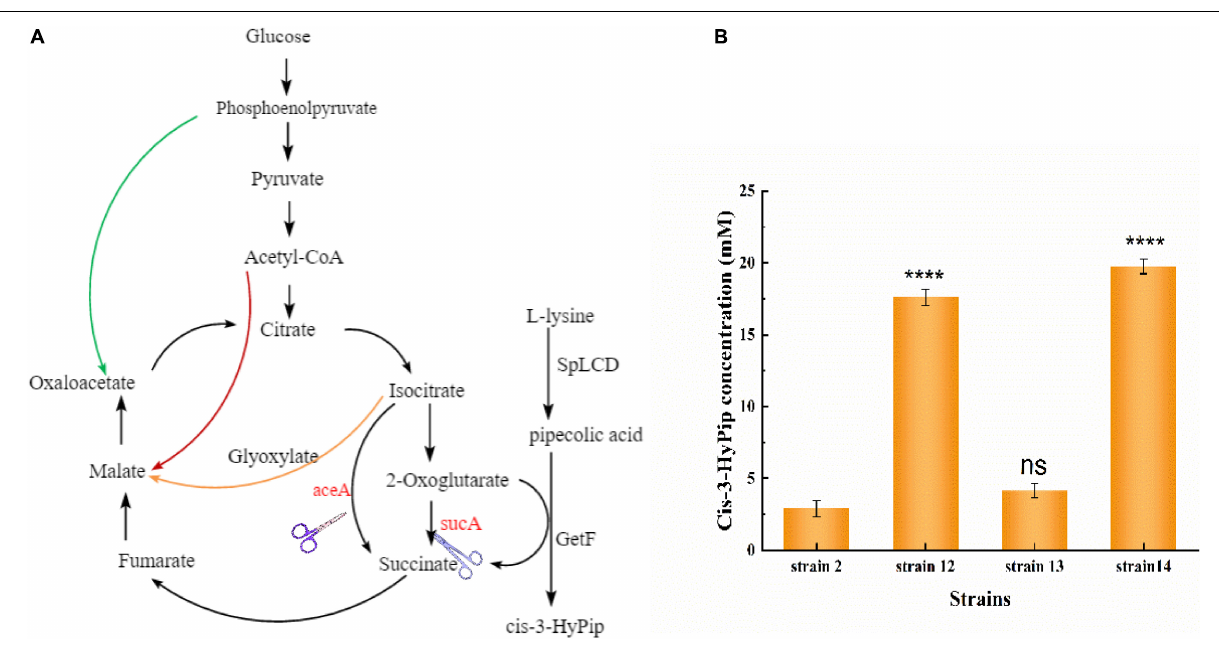
FIGURE 4 | Reconstitution of the TCA cycle using GetF catalyzed reaction. (A) The manipulations to disrupt the TCA cycle and glyoxylate bypass. (B) Effect of sucA and aceA gene deletion on cis-3-HyPip production, strain 12 [ E. coli BL21(DE3) (cid:49) sucA pETduet-1-29- getf -RBS(T7)- splcd ], strain 13 [ E. coli BL21(DE3) (cid:49) aceA pETduet-1-29- getf -RBS(T7)- splcd ], strain 14 [ E. coli BL21(DE3) (cid:49) sucA (cid:49) aceA pETduet-1-29- getf -RBS(T7)- splcd ]. **** P <